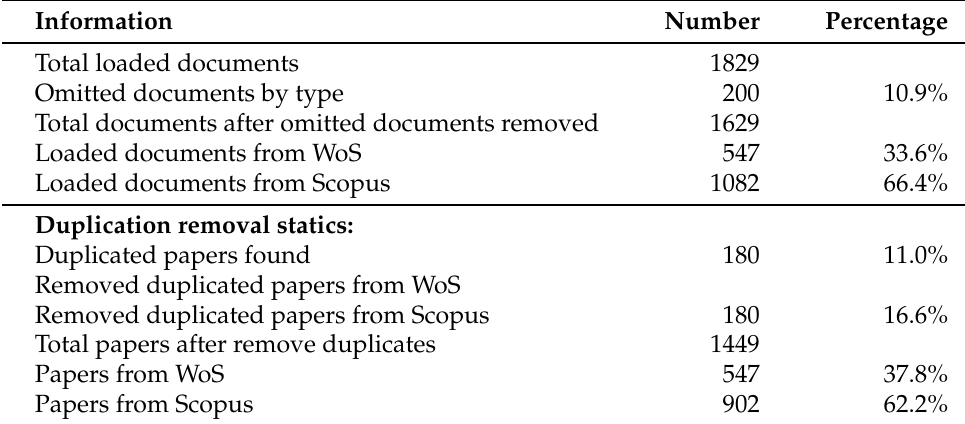
Table 2. Preprocess brief with ScientoPy for the dataset obtained from WoS and